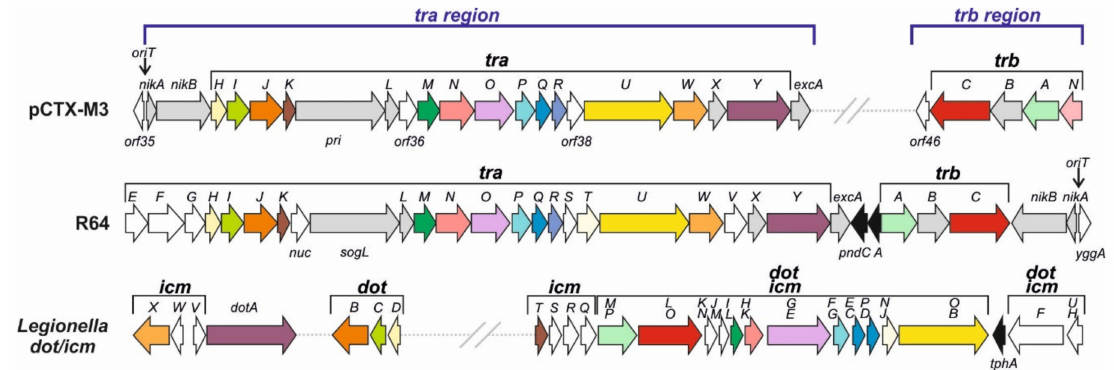
Figure 2. Gene organization of the transfer regions of pCTX-M3 and R64 and the dot/icm region of Legionella pneumophila . ORFs homologous in all systems are indicated by coloring. ORFs homologous in both plasmids are shown in grey, and those unique to one system only are shown in white. Gene group designation is indicated in brackets and individual genes are marked with appropriate letters. ORFs unrelated to the conjugation system are shown as black